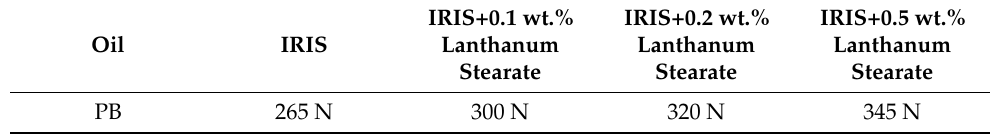
Table 5. P B values of IRIS and